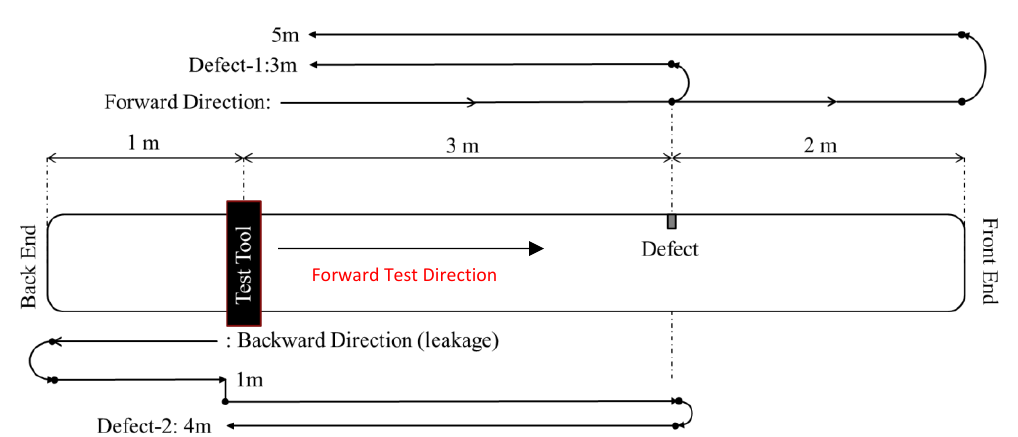
Figure 9. Torsional mode reception route in the FEM test cases.